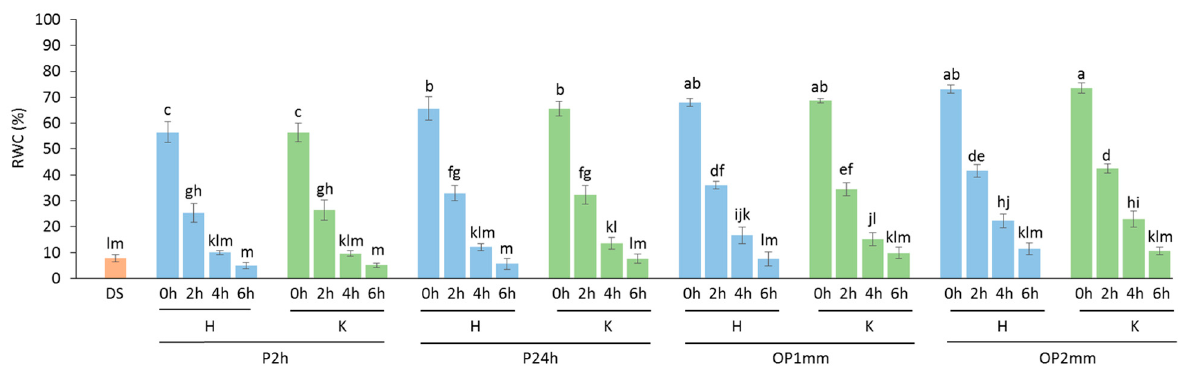
Figure 2. Relative water content (RWC) measured during dry-back of M. truncatula seeds subjected to short/prolonged priming and mild/severe overpriming, considering hydropriming (blue histograms) and kinetin-mediated hormopriming (green histograms). DS, dry seed; P2h, 2 h-priming; P24h, 24 h-priming; OP1mm, hydroprimed seeds with 1 mm radicle protrusion; OP2mm, hydroprimed seeds with 2 mm radicle protrusion; H, hydropriming; K, hormopriming. Means with common superscript letters are not significantly different ( p < 0.05) as analyzed with two-way ANOVA and Tukey